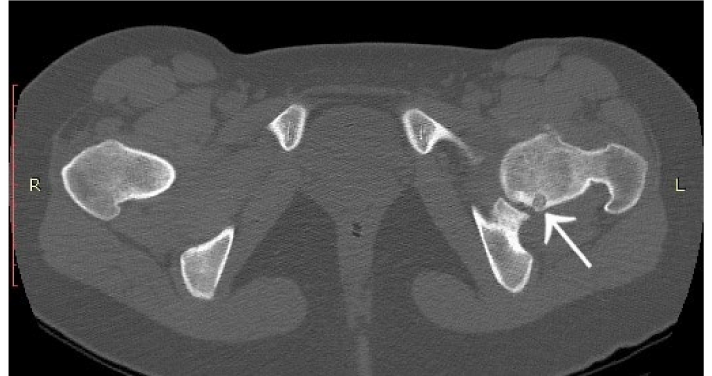
Figure 13. CT scan showing a focus of OO (arrow) in the left femoral